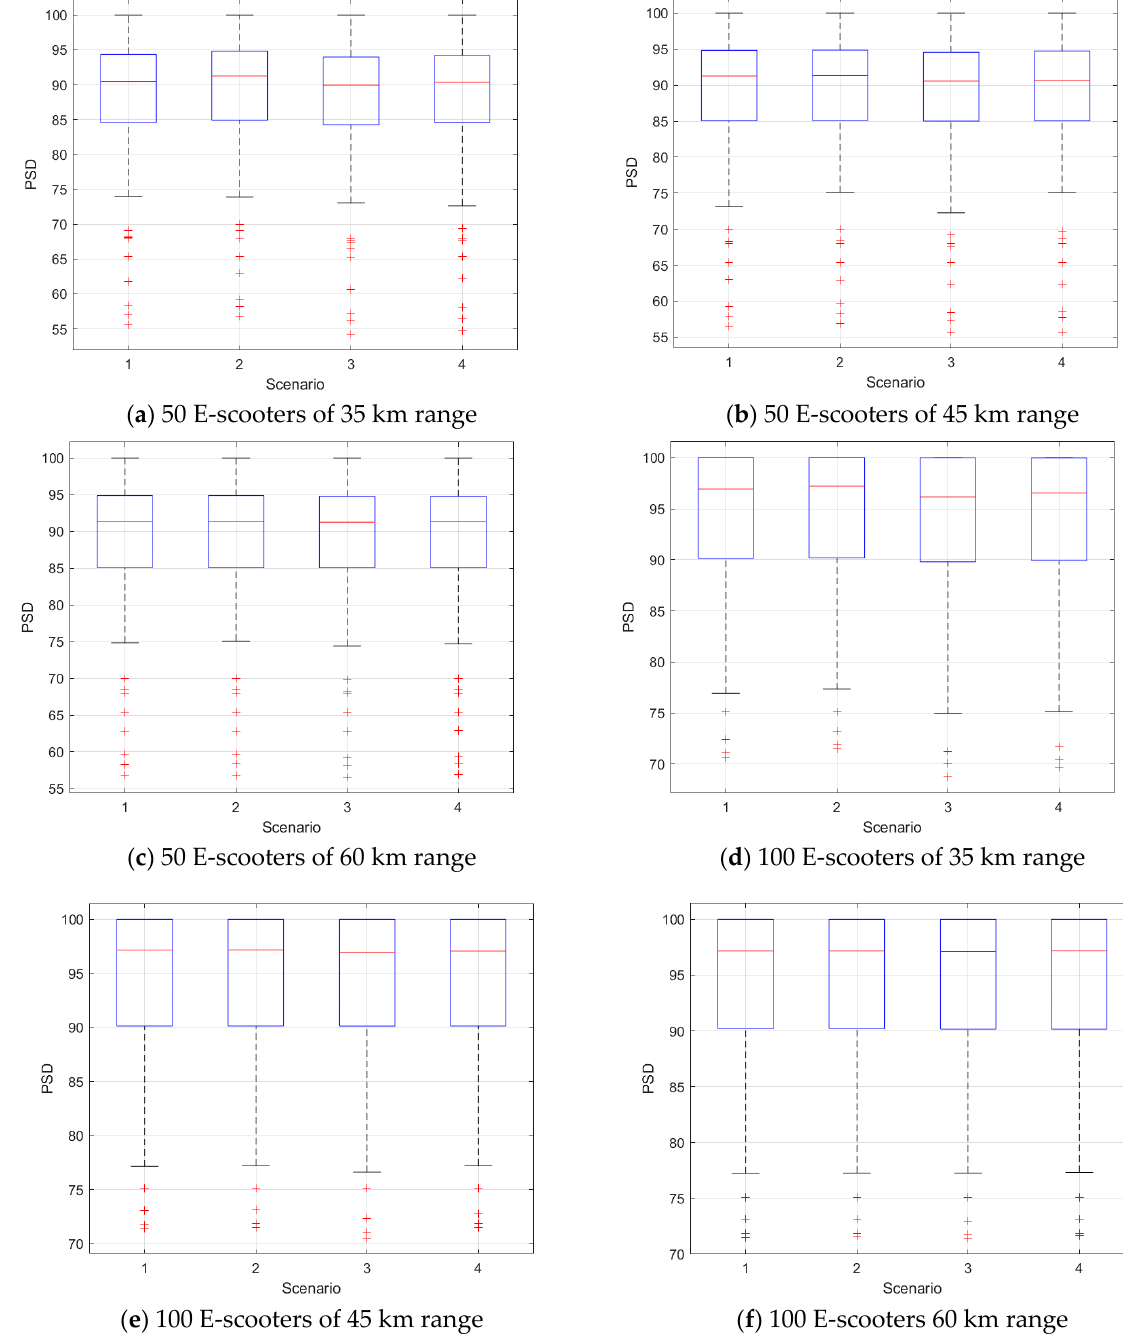
Figure 3. PSD results at different scenarios, number of e-scooters at each census tract, and battery ranges. Table 4. P values of the scenario’s indicator variables for the PSD models.